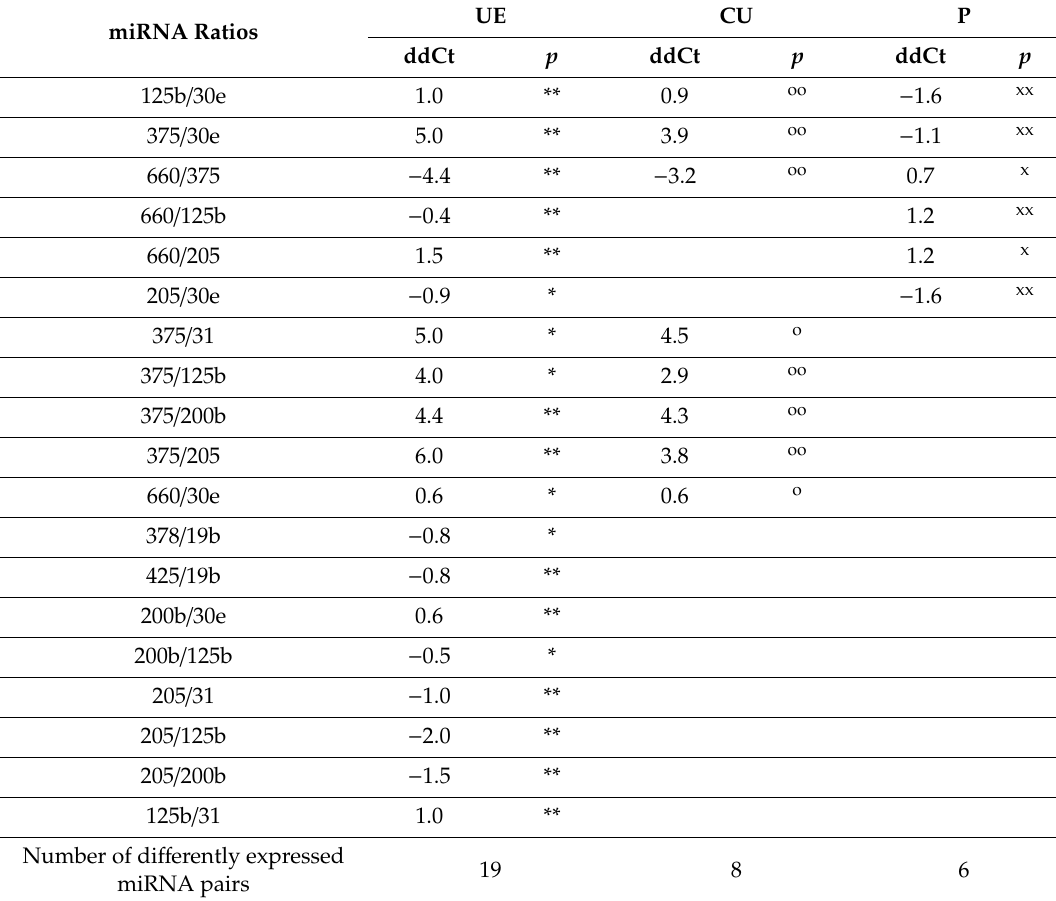
Table 2. ddCt mean values for di ff erentially expressed miRNA pairs after RP and before RP. UE CU P miRNA Ratios ddCt p ddCt